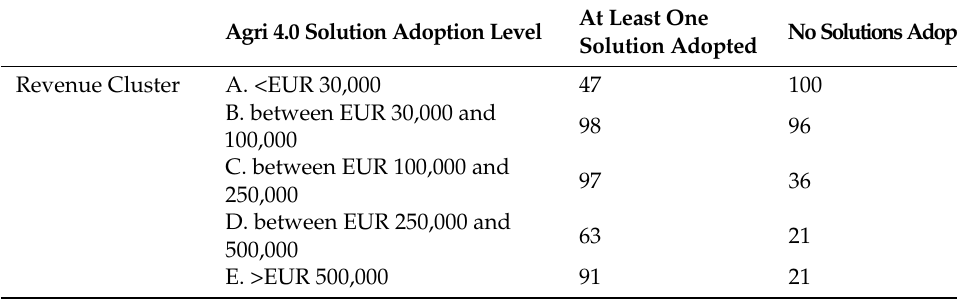
Table 9. Pearson’s χ 2 test for adoption level and revenue Table 9. Pearson ’s χ 2 test for adoption level and revenue clusters.